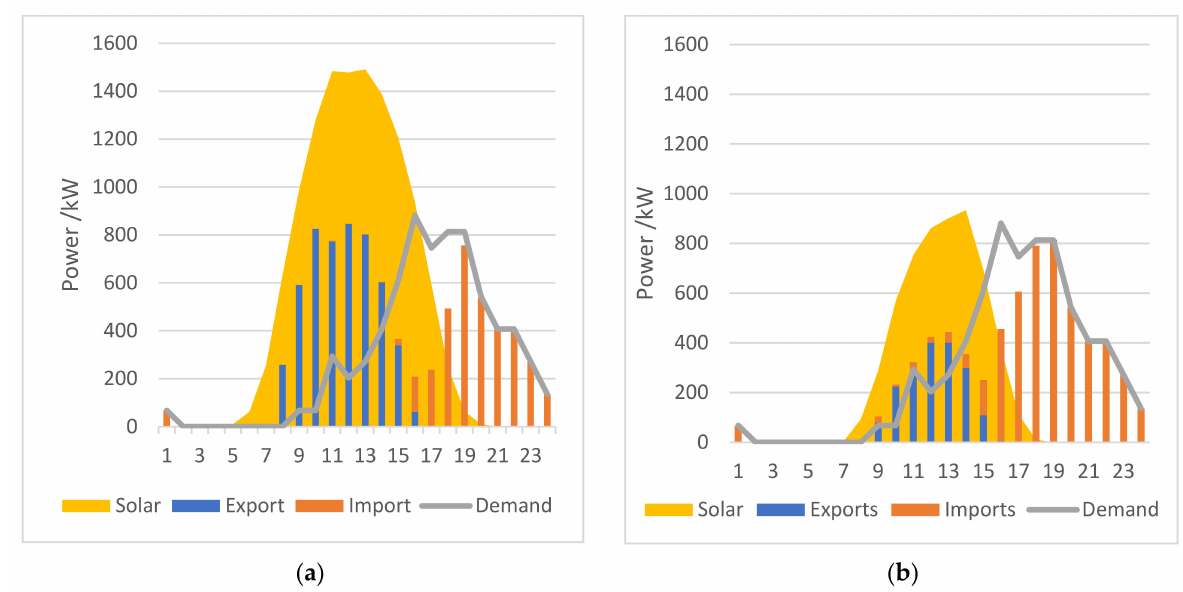
Figure 14. Fast-charge charging profile hourly average values per day of PV output, energy imports, energy exports, and demand. ( a ) Summer. ( b ) Winter.